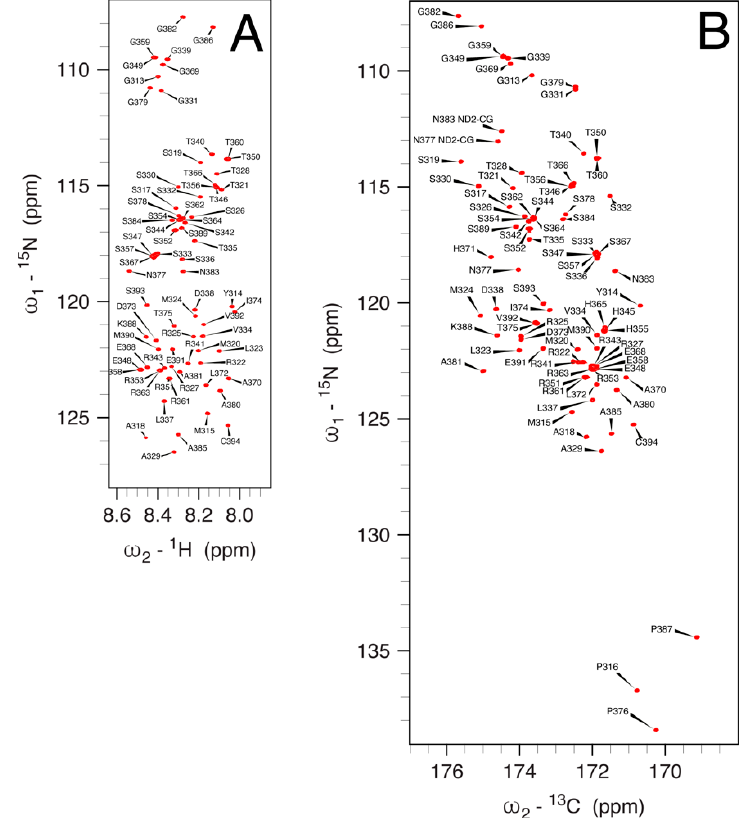
Figure 4. ( A ) 1.2 GHz (28.2 T) 2D 1 H, 15 N BEST-TROSY spectrum and ( B ) 700 MHz (16.4 T) 2D CON spectrum obtained by 13 C direct detection, acquired at 298 K on samples of 13 C, 15 N labeled h NDRG1-